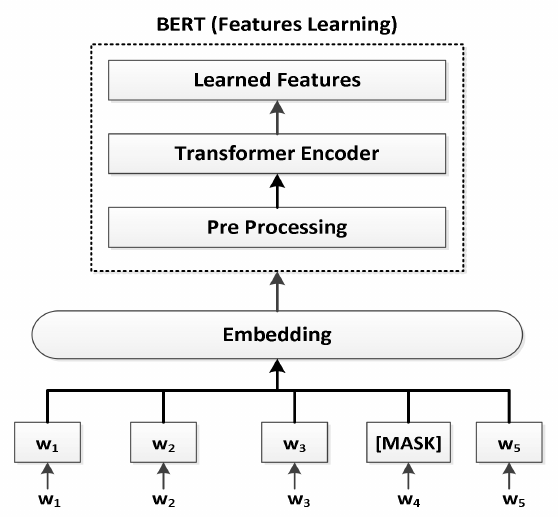
Figure 3. Feature mapping with